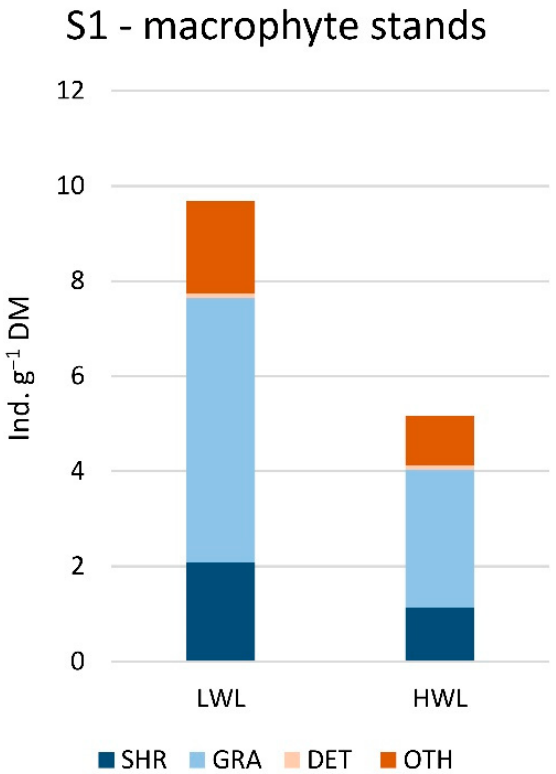
Figure 5. Gastropod functional feeding groups within the macrophyte stands of S1. Abbreviations are provided in Materials and Methods.